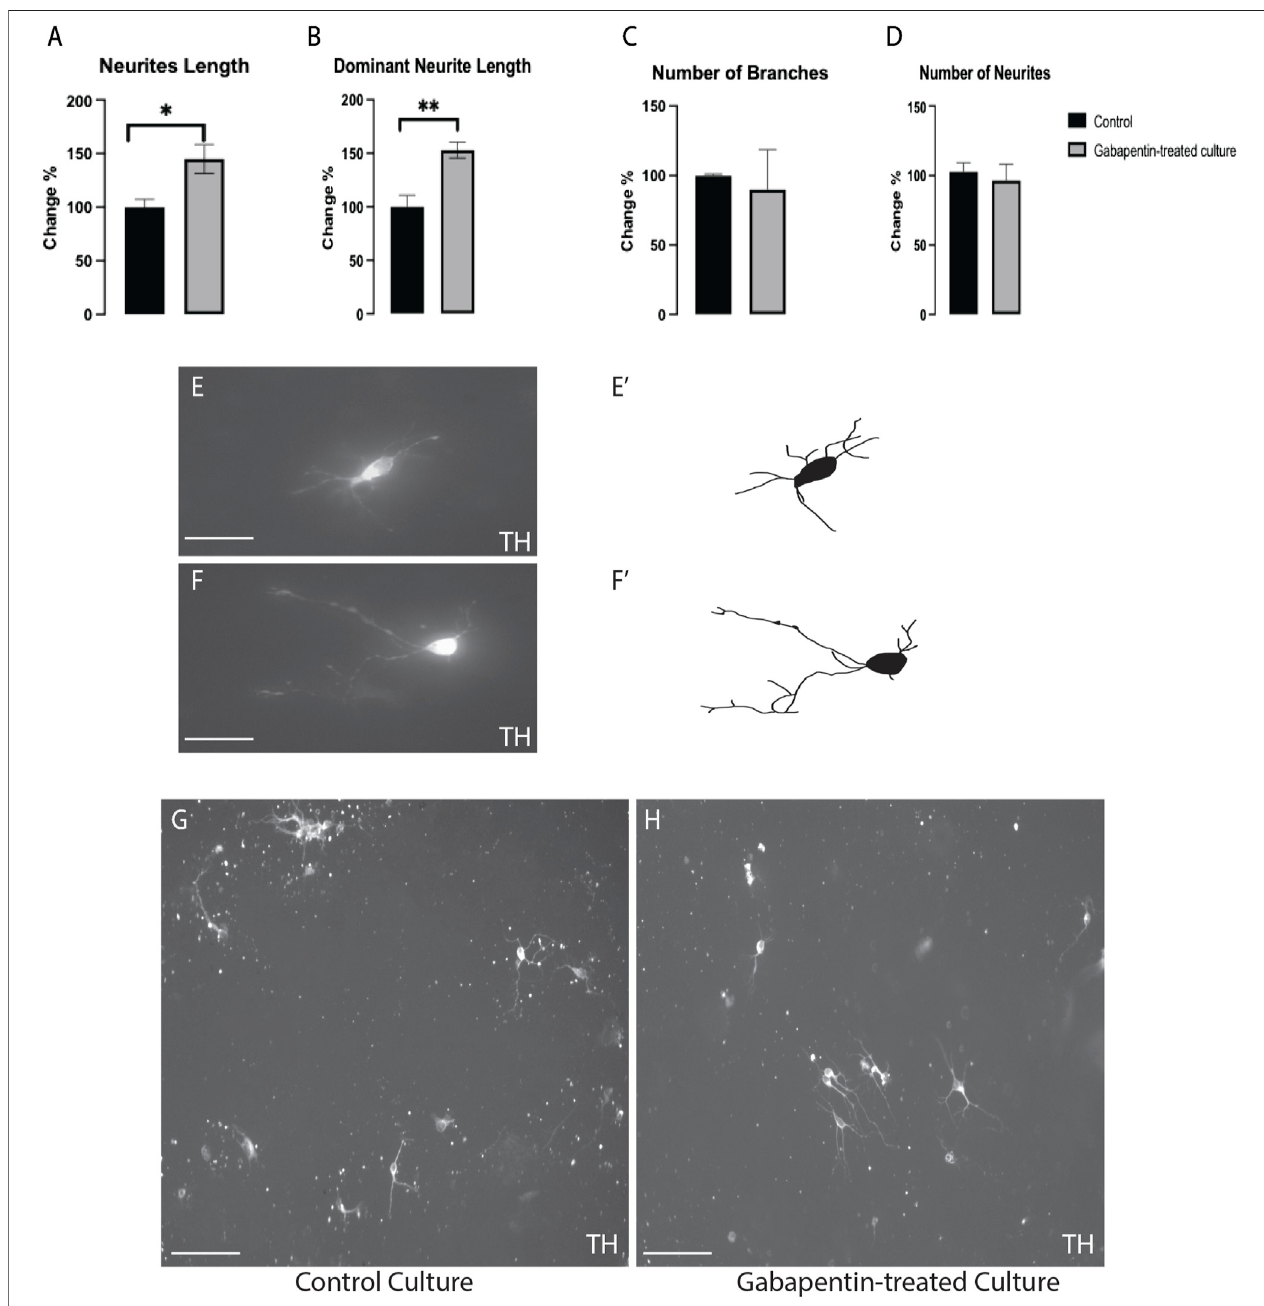
FIGURE 3 | Gabapentin-induced elongation observed in total neurite length (A) and dominant neurite length (B) of TH + vmDA neurons. TH + vmDA neurons showing no signi fi cant changesin the number of branches (C) and neurites (D) of in response togabapentin treatment. Representative images and illustration for vmDA neurons immunolabeled with TH in both groups; control (E,E ’ ) and gabapentin-treated (F,F ’ ) show the increase in neurites elongation in response to gabapentin exposure. (G,H) images show large fi eld of view (20x) for both groups; control and gabapentin treated cultures, respectively. Scale bar = 50 um (E,F) . Scale bar = 10 um (G,H) . Data are represented as mean ± SEM, n = 4 experiments. * p < 0.05.